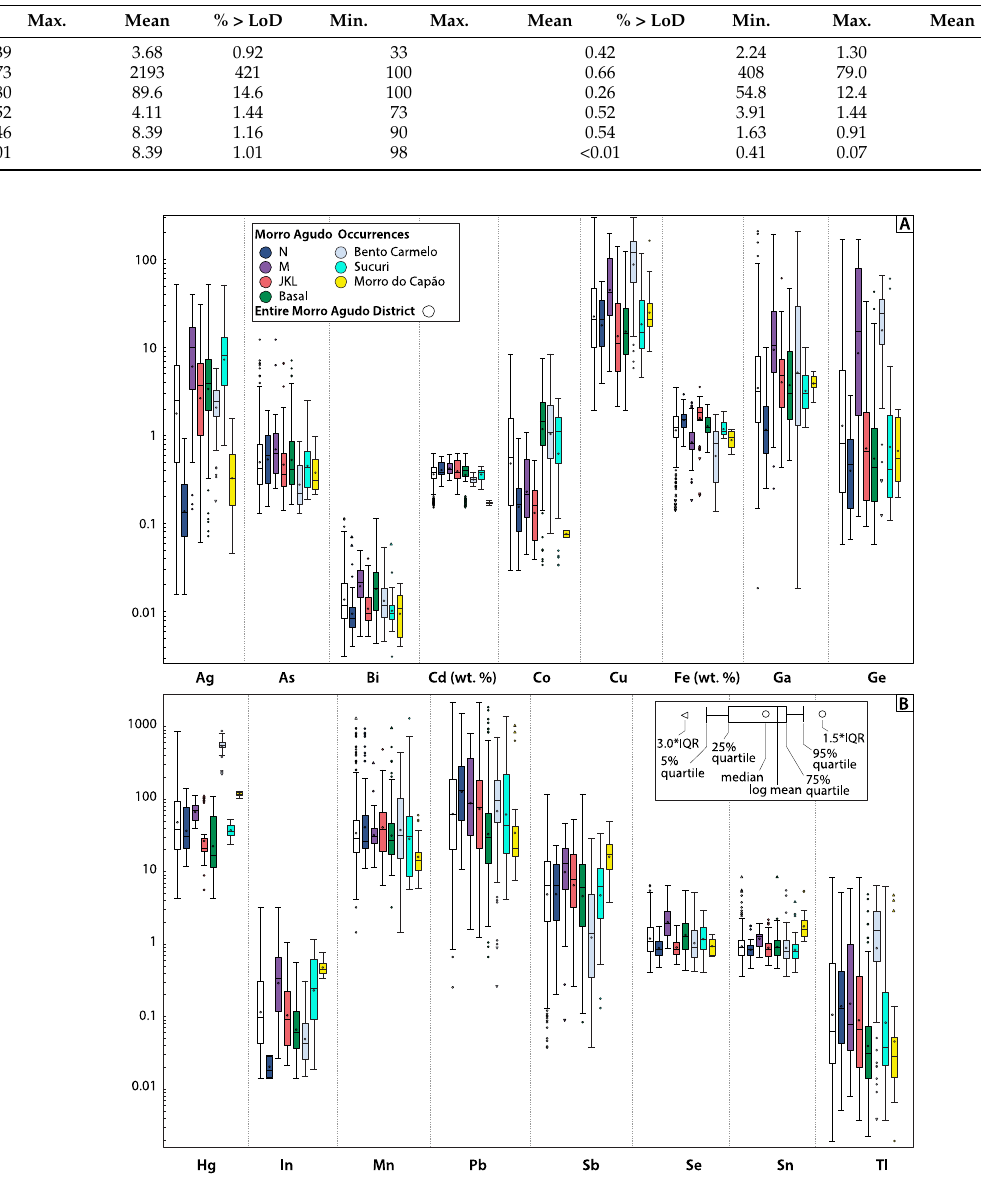
Figure 8. Box-and-whisker plots of trace elements ( A ) Ag, As, Bi, Cd, Co, Cu, Fe, Ga, Ge, ( B ) Hg, In, Mn, Pb, Sb, Se, Sn, and Tl in sphalerite within the Morro Agudo deposit and other district occurrences. All units are in ppm except Cd and Fe (wt.%). Note the logarithmic scale and corresponding mean value.